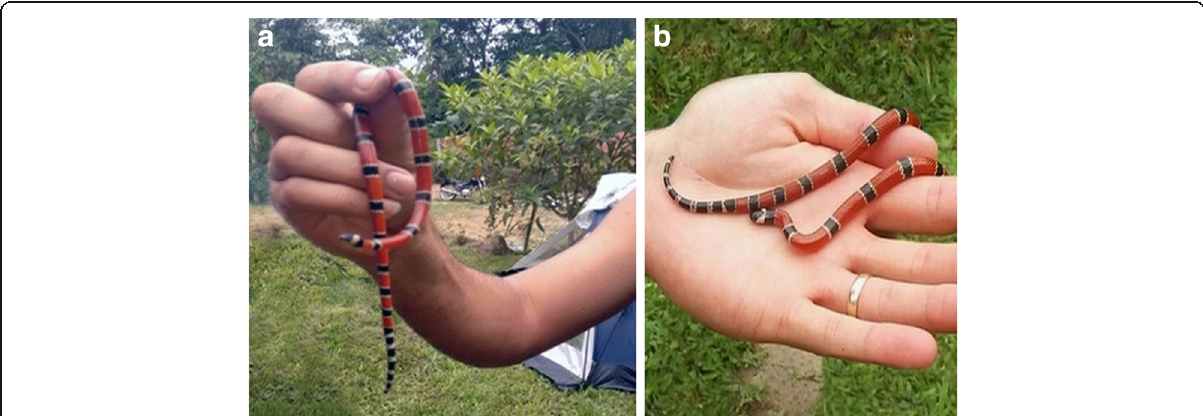
Fig. 2 Handling of a venomous coral snake, without use of suitable equipment